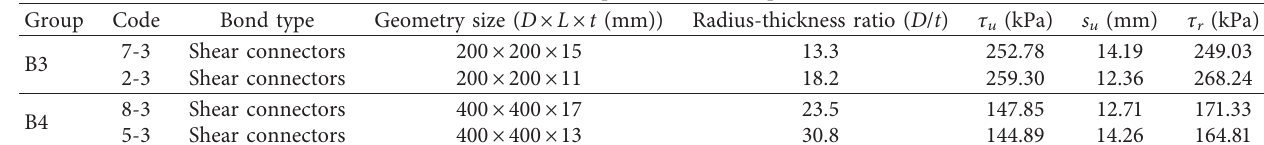
Figure 9: τ − s curves of Group B-1 and B-2. (a) τ − s curves of Group B-1. (b) τ − s curves of Group B-2. Table 8: Test results of specimens of Groups B-3 and B-4.